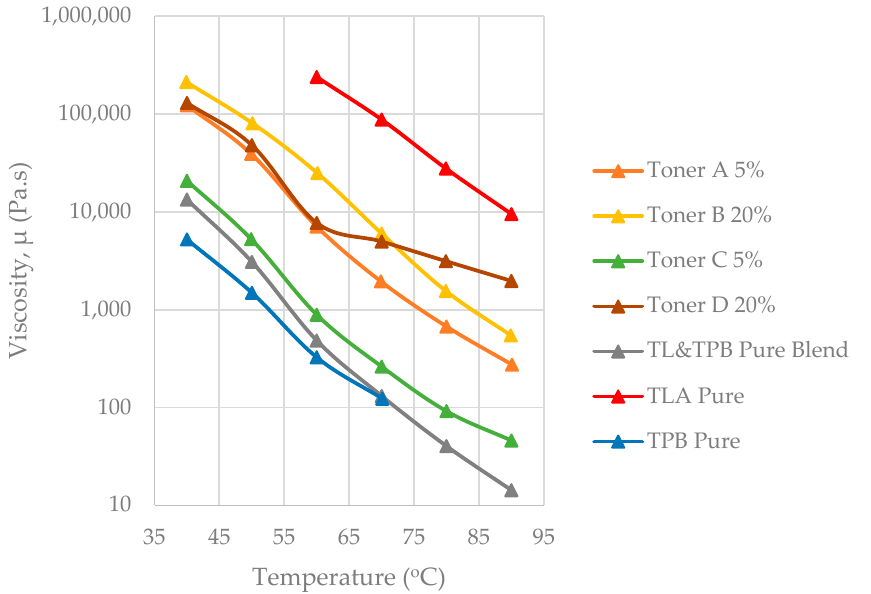
Figure 9. The effect of temperature on viscosity ( µ ) of the various optimized toner blends, unmodified TLA/TPB paving binder, and pure TLA and TPB.